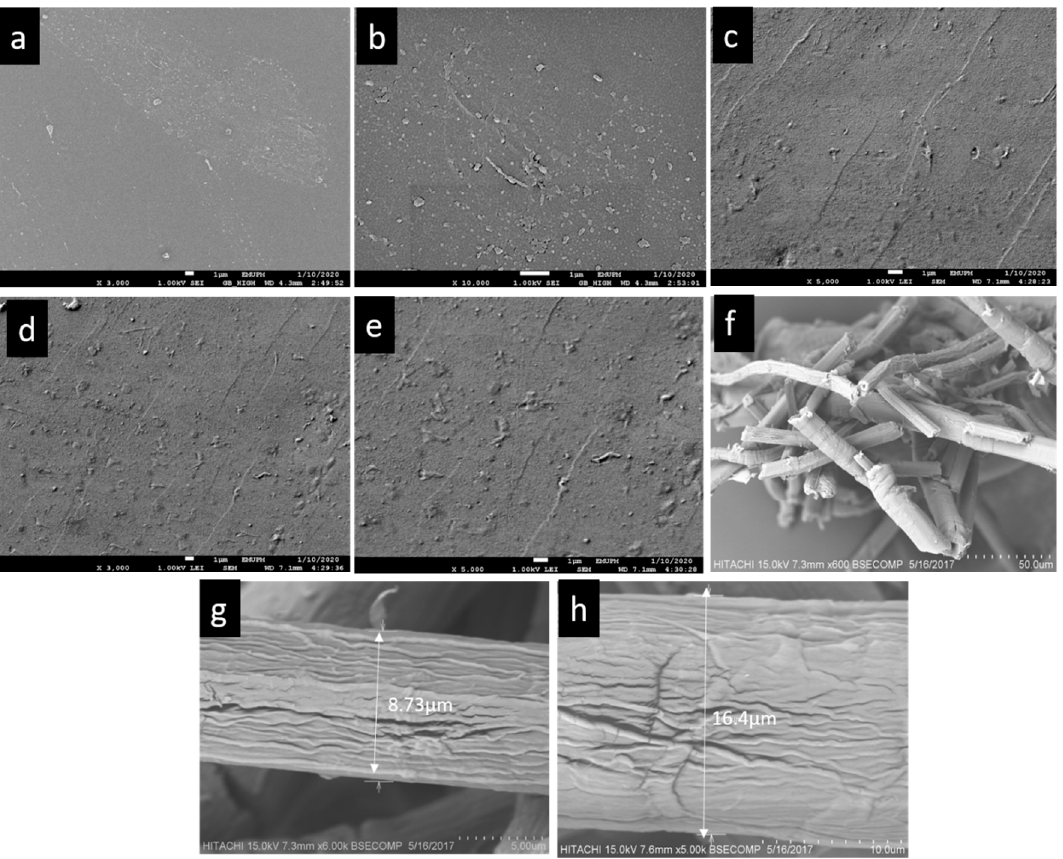
Figure 1. FESEM images of composite films ( a ) M1, ( b ) M2, ( c ) M3, ( d ) M4, ( e ) M5, ( f , g , h ) SEM images of MCC.